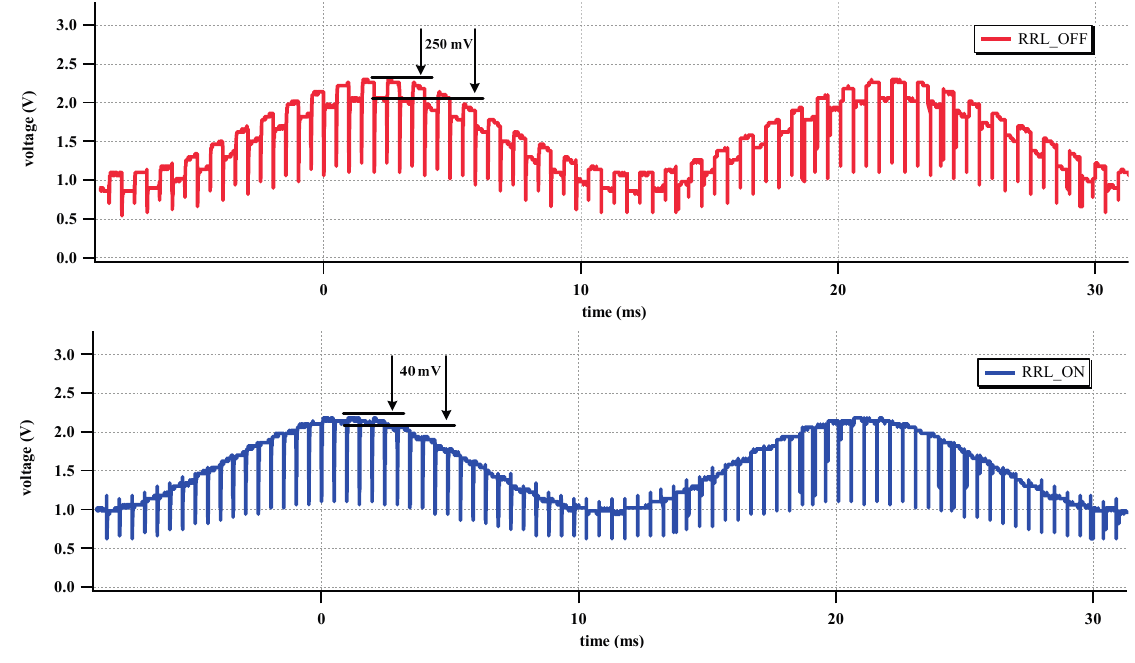
Figure 15. Measured time domain output with the